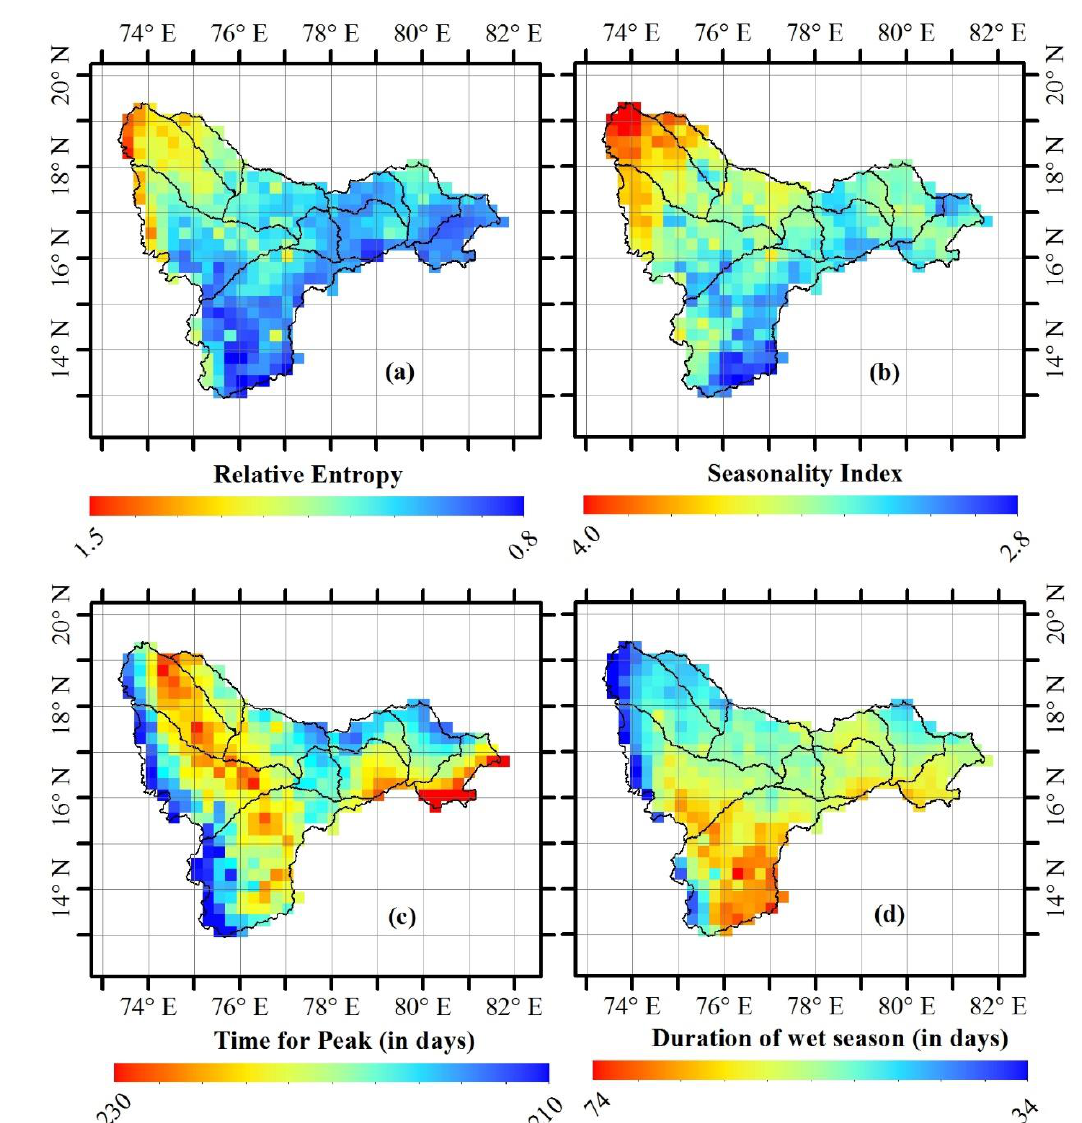
Figure 2. Represents spatial patterns of yearly mean for a period from 2002 to 2015 of (a) Relative entropy, (b) Seasonality Index, (c) Time for peak monsoon (in days), (d) Duration of wet season (in